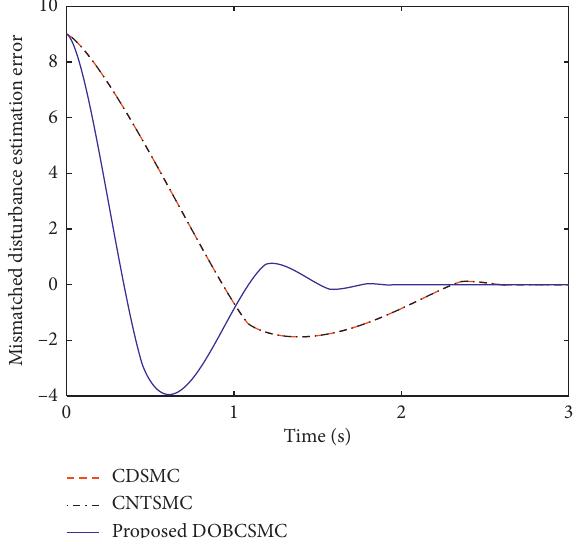
Figure 3: Simulation results of Scenario I—mismatched distur- bance estimation error.